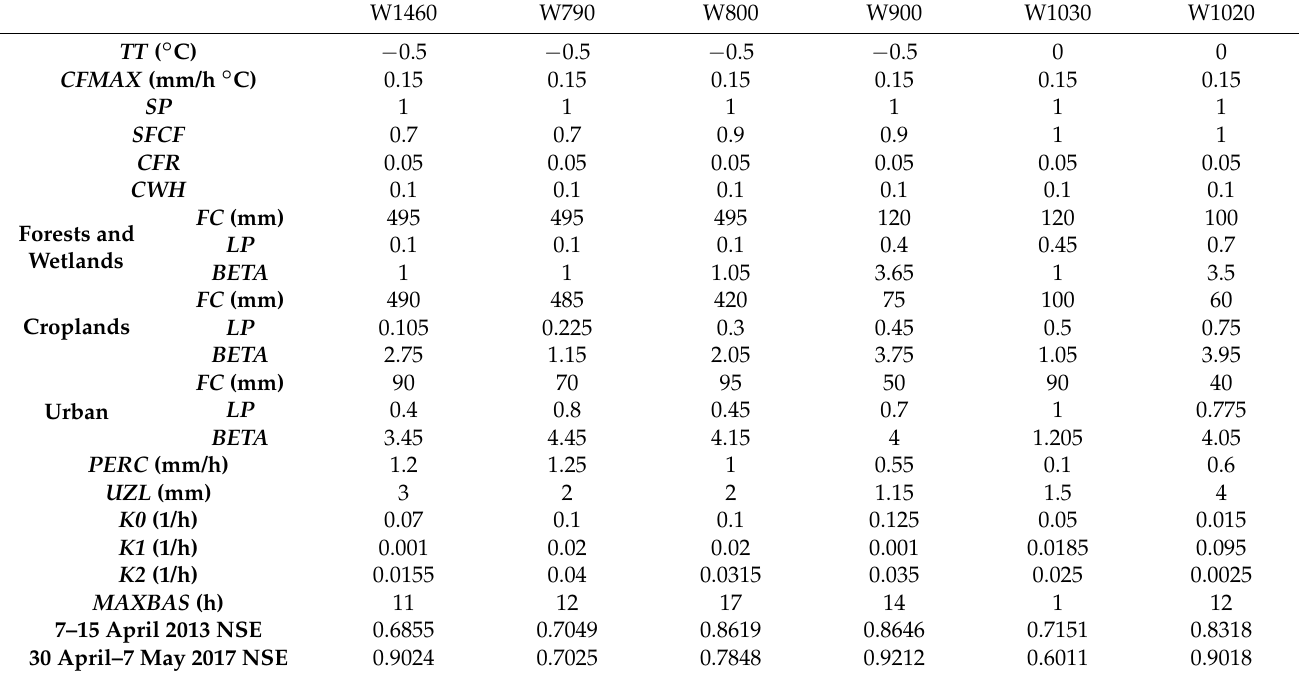
Table 13. Optimal values’ parameters via calibration of the HBV-light model for the events of 7–15 April 2013 and 30 April–7 May